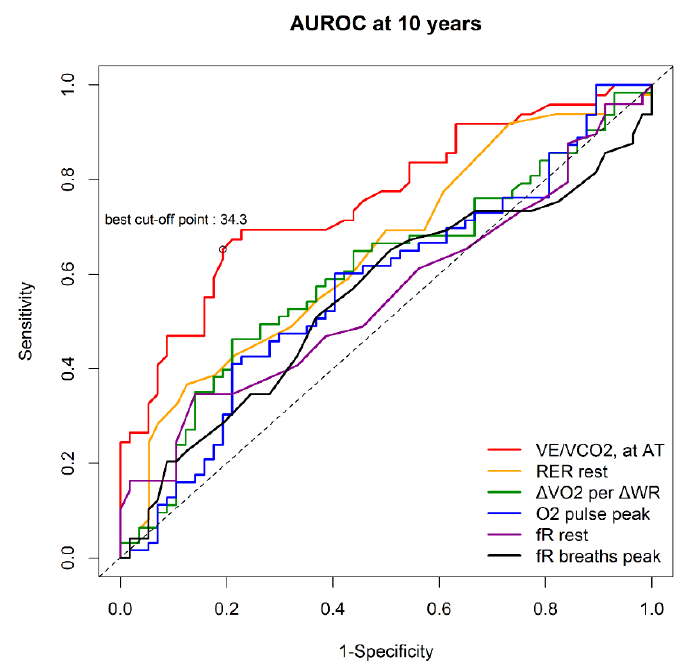
Figure 1. In ROC analyses of different CPET parameters, the only significant predictor of heart failure hospitalization was the VE/VCO2 at AT. Best cut-off point: 34.3, AUROC: 0.756. VE/VCO2 at AT: ventilatory equivalent for carbon dioxide at anaerobic threshold, RER: respiratory exchange ratio; ∆ VO2 / ∆ WR: the ratio of increase in oxygen uptake to increase in work rate; fR rest: resting breathing rate; fR breath peak: peak exercise breathing rate; AUROC: area under receiver operating characteristic curve; CPET: cardiopulmonary exercise test.